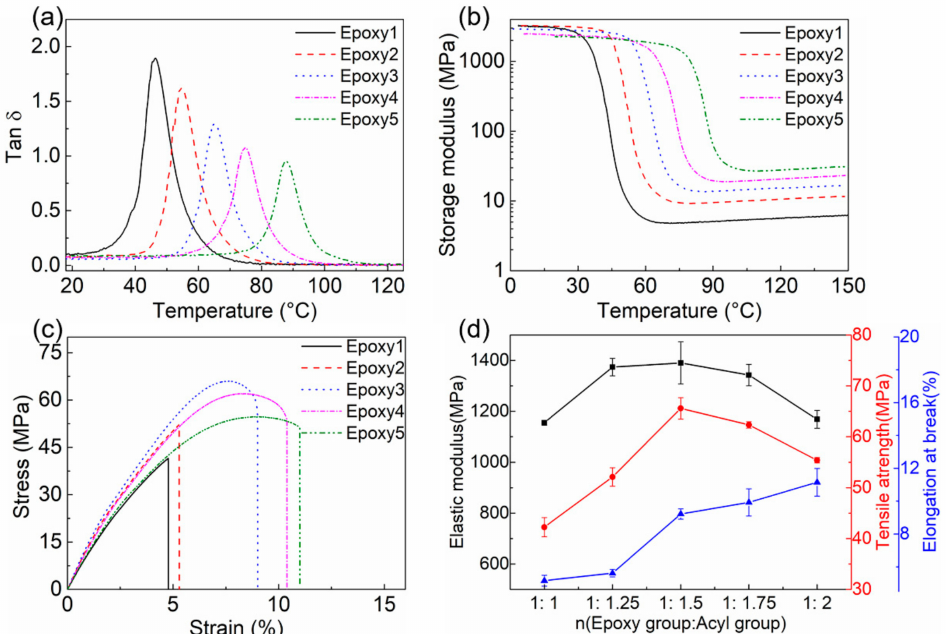
Figure 5. ( a ) Tan δ curves as a function of temperature. Take the temperature corresponding to the peak of the curve to be T g ; ( b ) Storage modulus curves of epoxy resins with different GA contents as a function of temperature; ( c ) Uniaxial tensile stress-strain curves of fresh epoxy resins; ( d ) The changes of elastic modulus, tensile strength, and elongation at break with the ratio of the epoxy group and acyl group. Table 2. Effect of the stoichiometric ratio of the epoxy group and acyl group ( r ) on properties of epoxy resins.